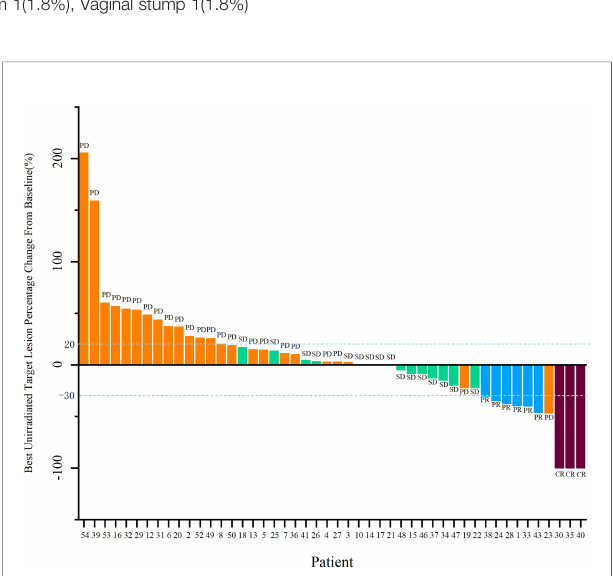
FIGURE 2 | Consort diagram.